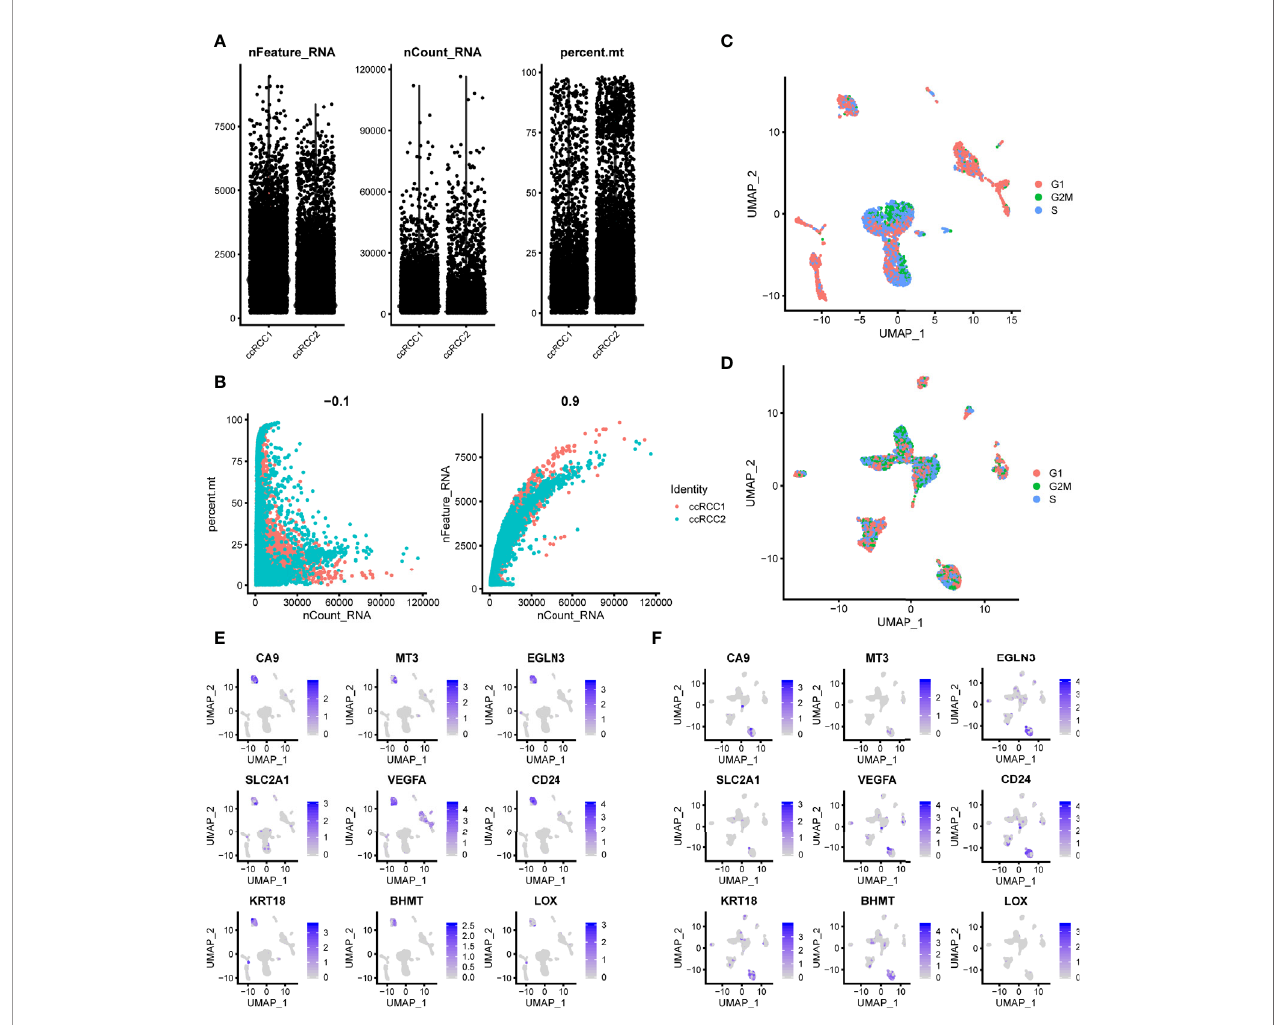
FIGURE 2 | Quality control (QC) of the scRNA-seq data. (A) QC of bilateral ccRCC scRNA-seq data. nFeature, number of genes; nCount, unique molecular identi fi ers (UMIs); percent.mt, percentage of mitochondrial genes. (B) Relationship between the percentage of mitochondrial genes and the mRNA reads and between the amount and reads of mRNA. (C, D) Cell clustering results by eliminating the in fl uence of cell cycle genes. (E, F) The DEGs of ccRCC cells reported in previous study also veri fi ed in ccRCC1 (E) and ccRCC2 (F)